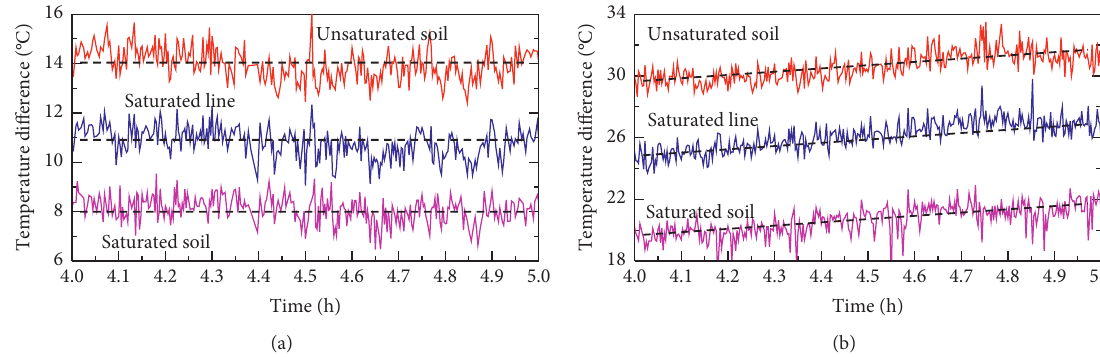
Figure 5: Variation of temperature difference under 4 to 5hours after heating: (a) 10 A; (b) 15A.